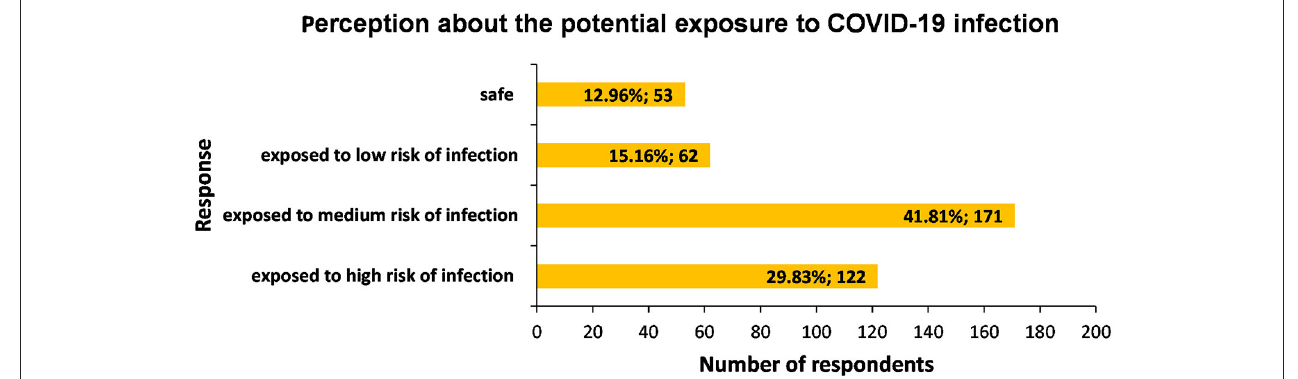
FIGURE 1 | Distribution of respondents ( n = 408) with respect to their perception about the potential exposure to COVID-19 infection at the workplace during confinement.